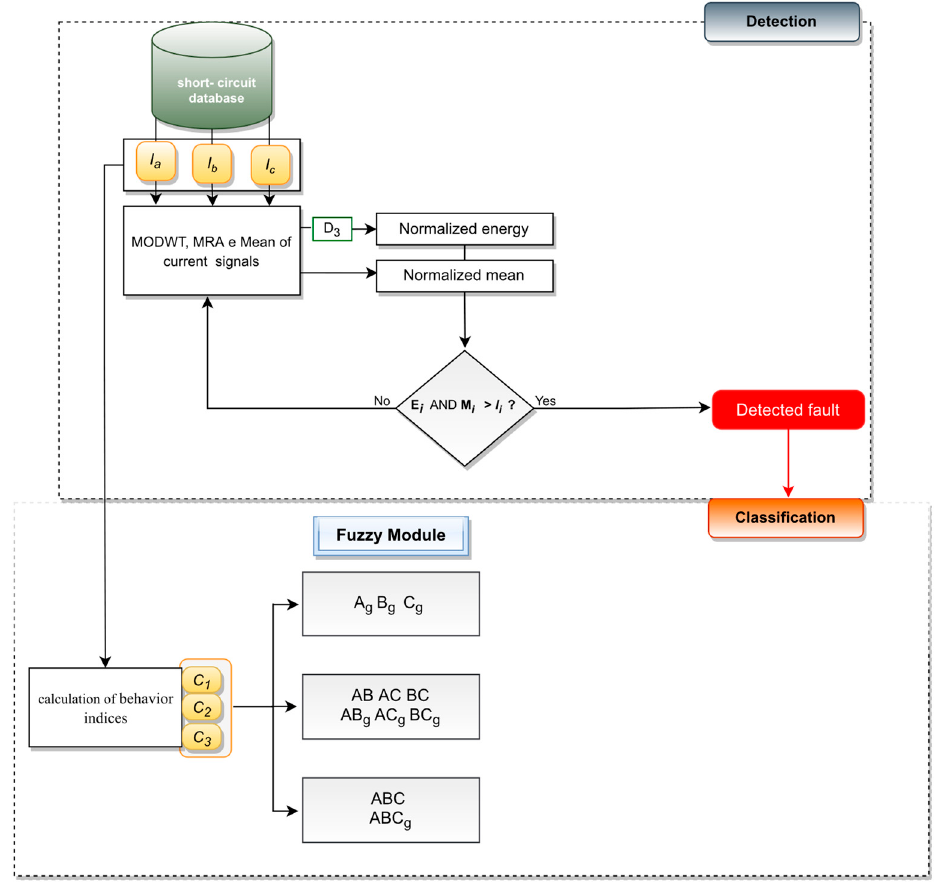
Figure 7. Flowchart with an overview of proposed methodology.